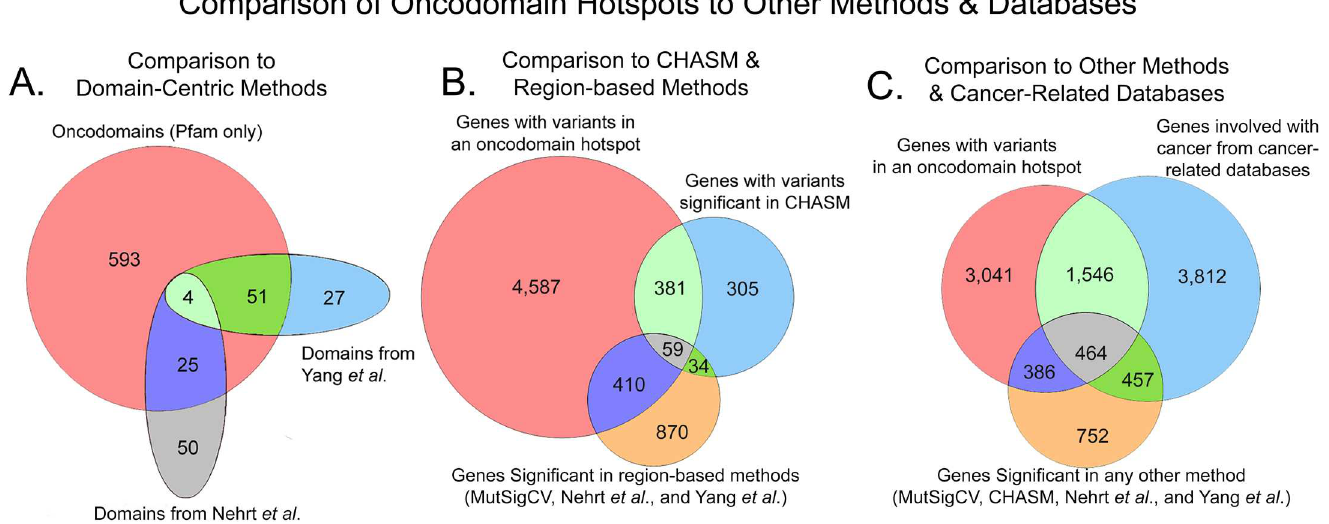
Fig 4. Comparison of oncodomain hotspots to other methods and